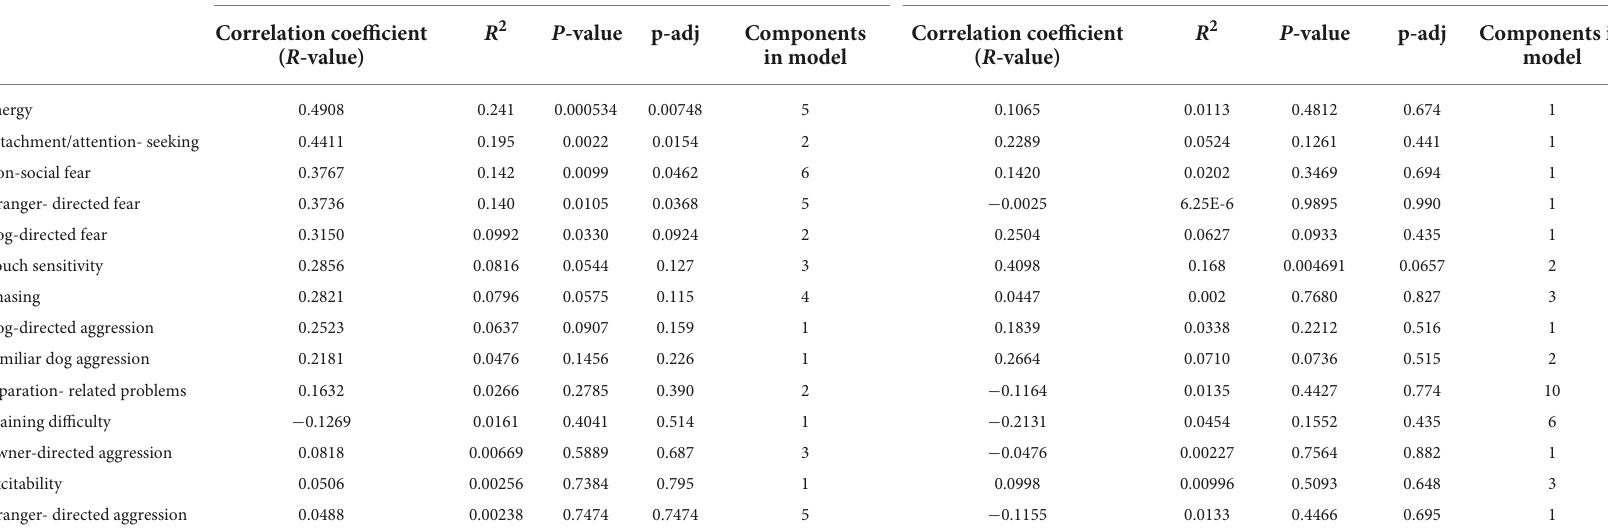
TABLE 1 Behavioral phenotype